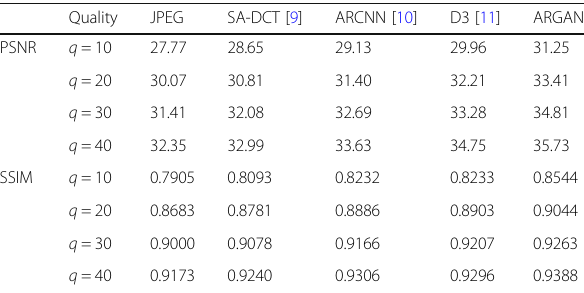
Table 3 The average results of PSNR (dB), SSIM on the LIVE1 dataset